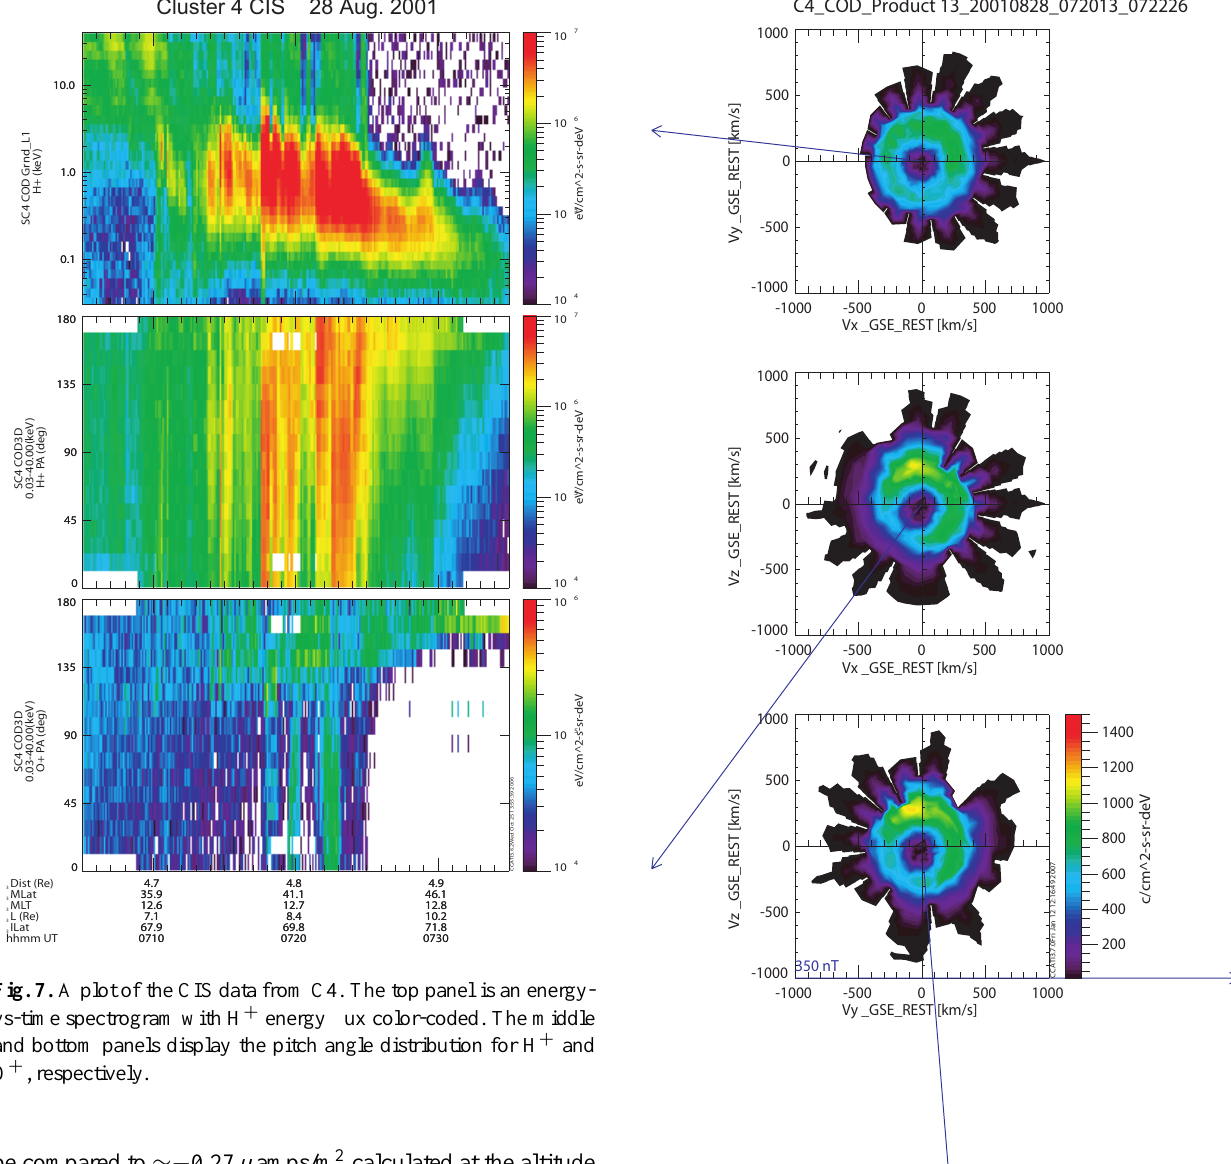
07:03:56 UT (MLT=12.77 h), and the Cluster-4 spacecraft at 07:01:06 UT (MLT=12.82 h) all are measuring high energy plasma in the auroral region, equatorward of the cusp. The DSIV is not observed by the Cluster satellites until IL ∼ 76 ◦ , which occurs about 10 min before the Polar